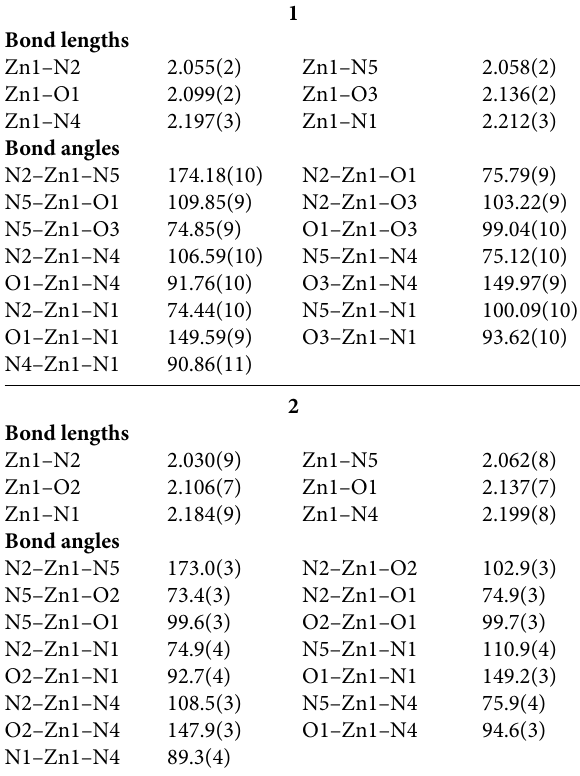
Table 2. Selected bond lengths (Å) and angles ( o ) for the